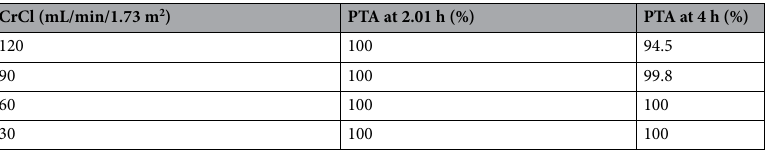
Table 3. Estimated probability target attainment (PTA) using PK simulations with four different CrCL profiles after a 2000 mg single dose of cefazolin. CrCL Creatinine clearance (mL/min) according to the CKD-EPI formula.